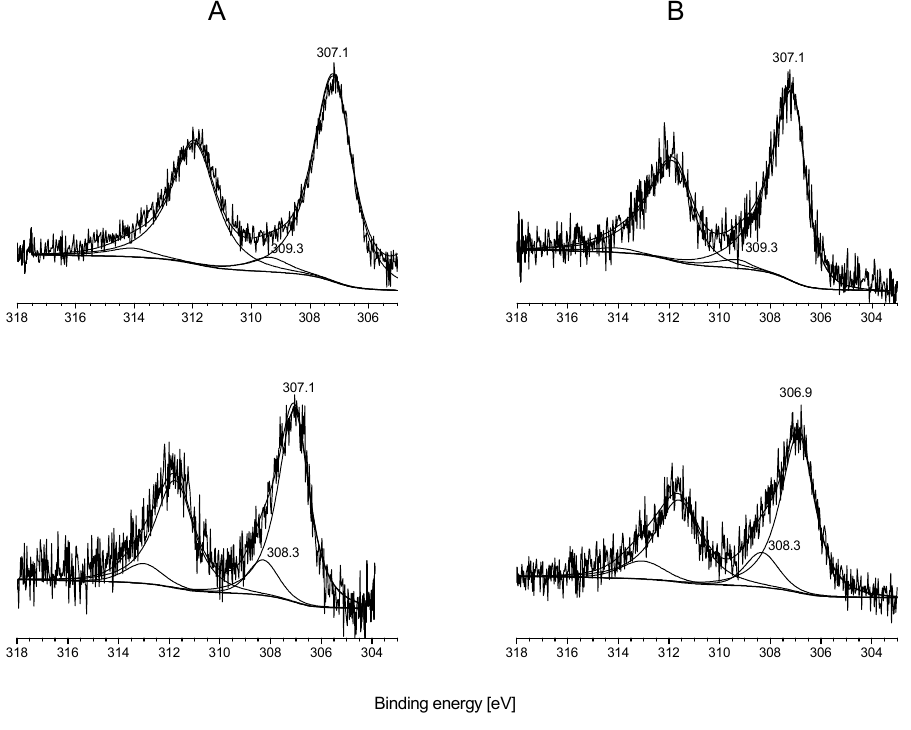
Figure 5. XP spectra of Rh 3d on titanate nanowire ( A ) and nanotube ( B ) with 1% Rh content (upper spectra) and 2% metal content (lower spectra). Reproduced from [70].